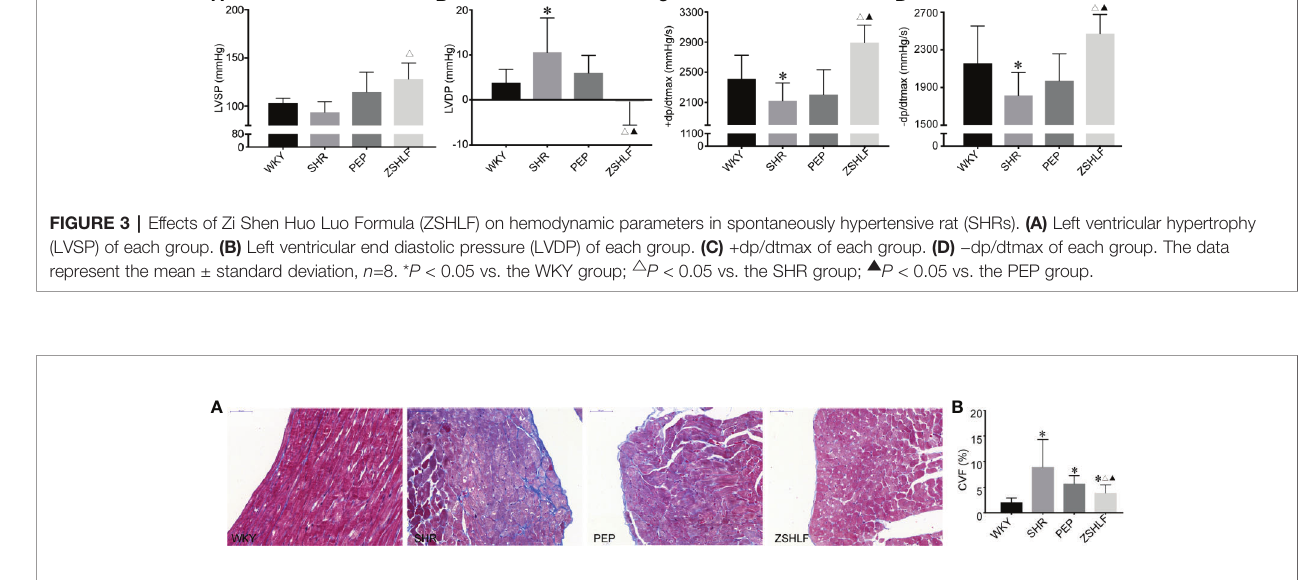
FIGURE 4 | Effects of Zi Shen Huo Luo Formula (ZSHLF) on the collagen fi bers of spontaneously hypertensive rat (SHRs). (A) Effect of ZSHLF on Masson staining in each group. (B) Effect of ZSHLF on the CVF in each group. The data represent the mean ± standard deviation, n =3. * P < 0.05 vs. the WKY group; △ P < 0.05 vs. the SHR group; ▲ P < 0.05 vs. the PEP group.